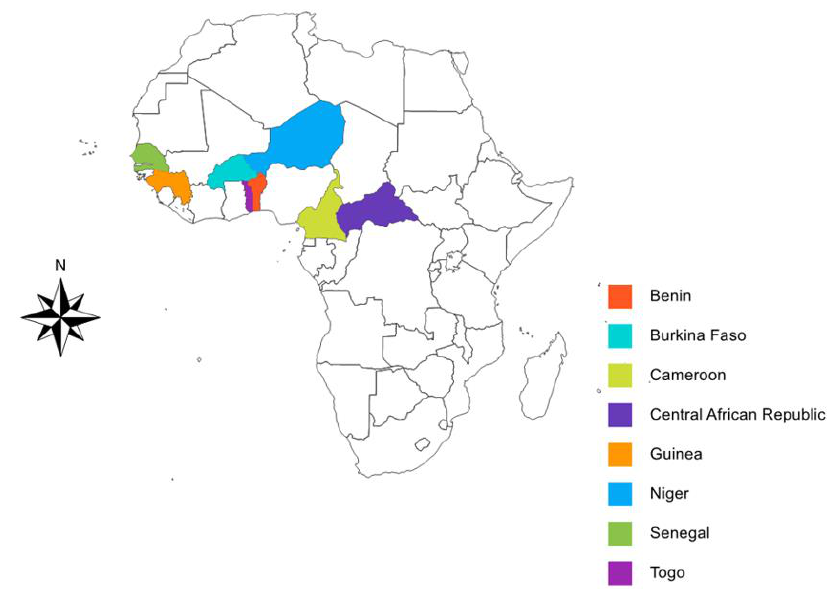
Figure 1. Countries with study sites included in this paper.